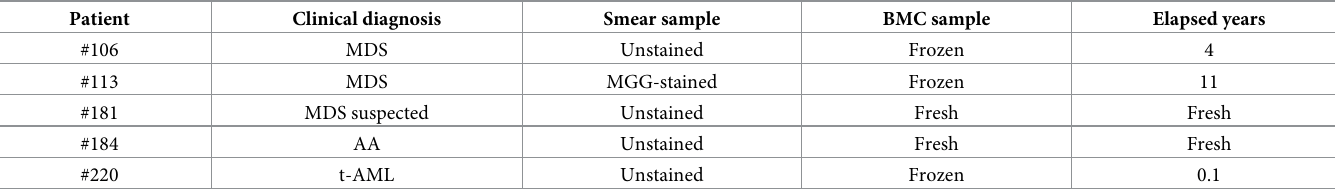
Table 1. Paired samples of bone marrow cells and